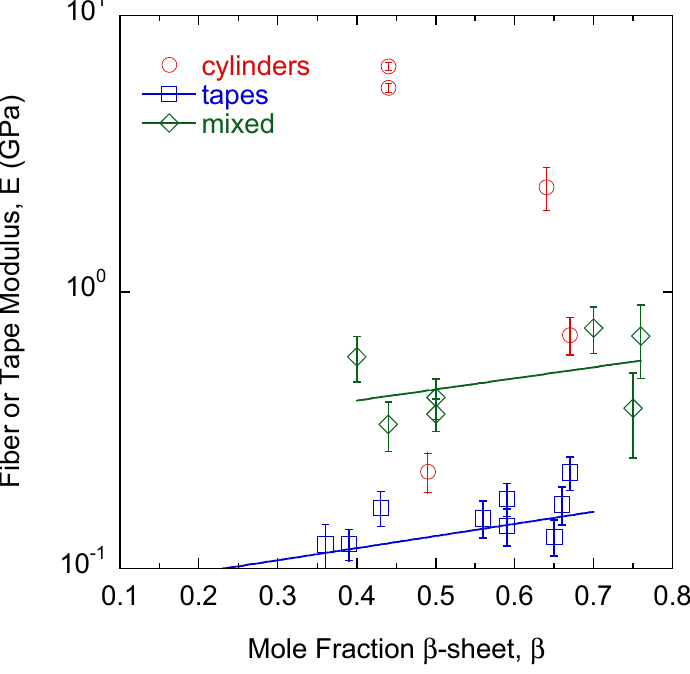
Figure 4. There is a slight dependence of tape and mixed morphology structure modulus, E, on β -sheet content, β . However, β -sheet content alone cannot differentiate the different types of structures